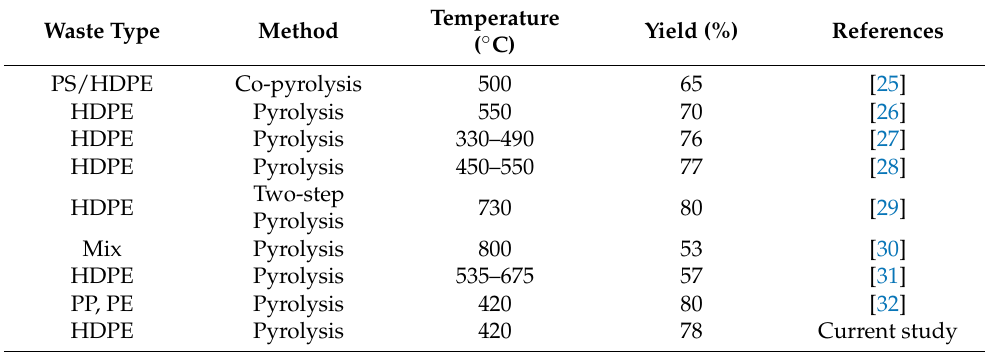
Table 9. A comparison of percentage yield of oil using different waste, temperatures, and